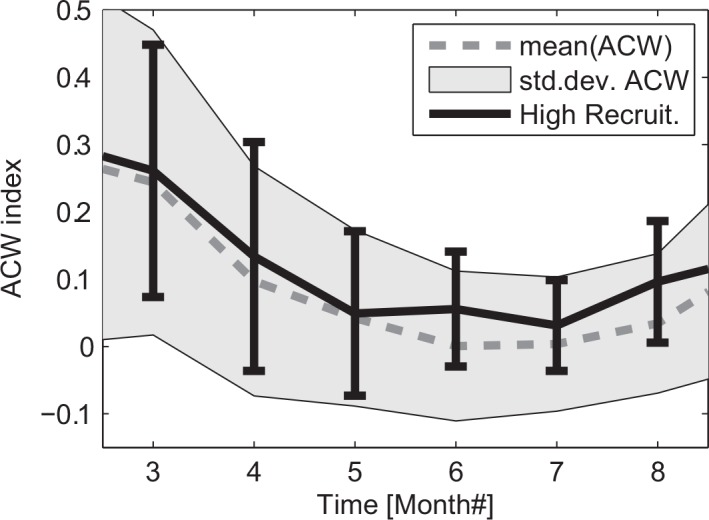
Indices for the Along Coast Wind component averaged between 64 to 68° N.The annual mean (dashed line) with corresponding standard deviation (gray area) are shown for the period 1948–2012. The similar values for the Along Coast Wind but limited to selected high NSSH recruitment years 1950, 1959, 1983 and 2002 are included with mean (solid line) and standard deviation (vertical bars). Note that the standard deviations are estimated based on weekly mean data.